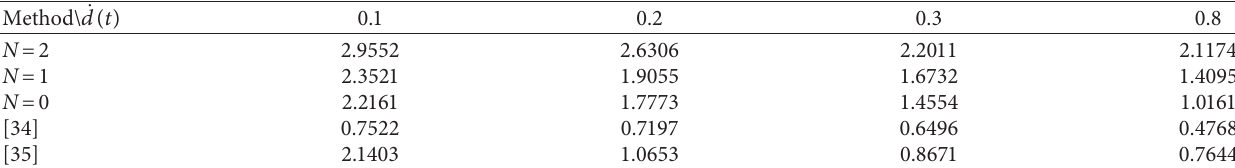
_ τ ( t )( d � − d � _ d ( t )) M for different 2 1